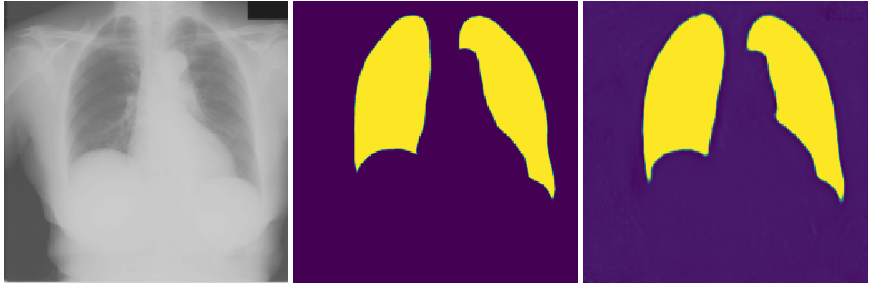
Figure 4. Worst segmentation dice score (0.776) visualization, ( left ): original image, ( middle ): ground truth, ( right ): predicted